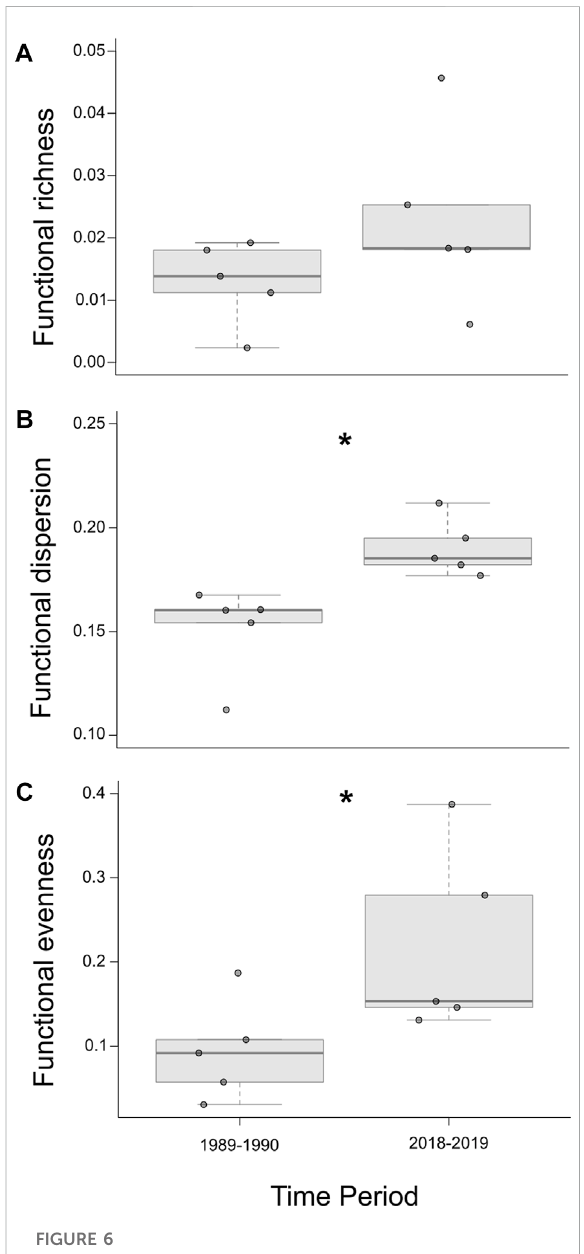
FIGURE 6 Boxplots of overall functional diversity comparisons: functional richness (A) , dispersion (B) , and evenness (C) between 1989 – 1990 and 2018 – 2019 surveys. A signi fi cant difference between metrics is designated by an asterisk (*; p <